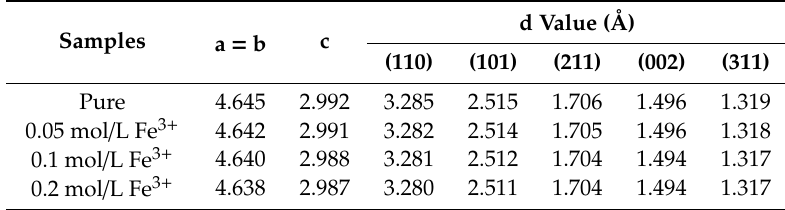
Figure 4. XRD patterns of Fe 3 + doped TiO 2 NTAs with various FeCl 3 solution concentrations and standard PDF cards of rutile phase TiO 2 and titanium. Table 2. Lattice parameters and interplanar crystal spacing (d values) of pure and Fe 3 + doped TiO 2 NTAs samples.